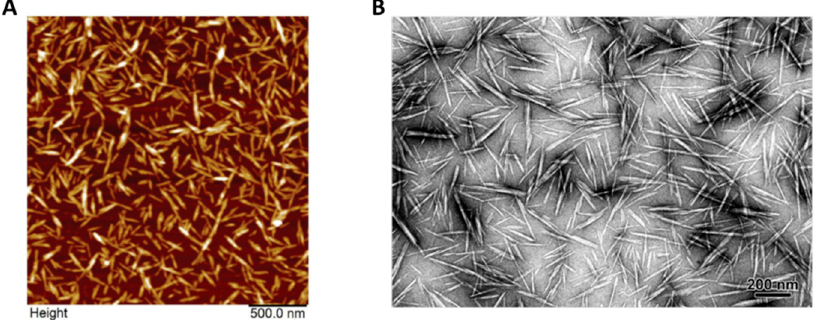
Figure 3. ( A ) AFM images of CNs deposited on mica and ( B ) TEM images of modified NC on the copper grid (reproduced with permission from author [36,37]).